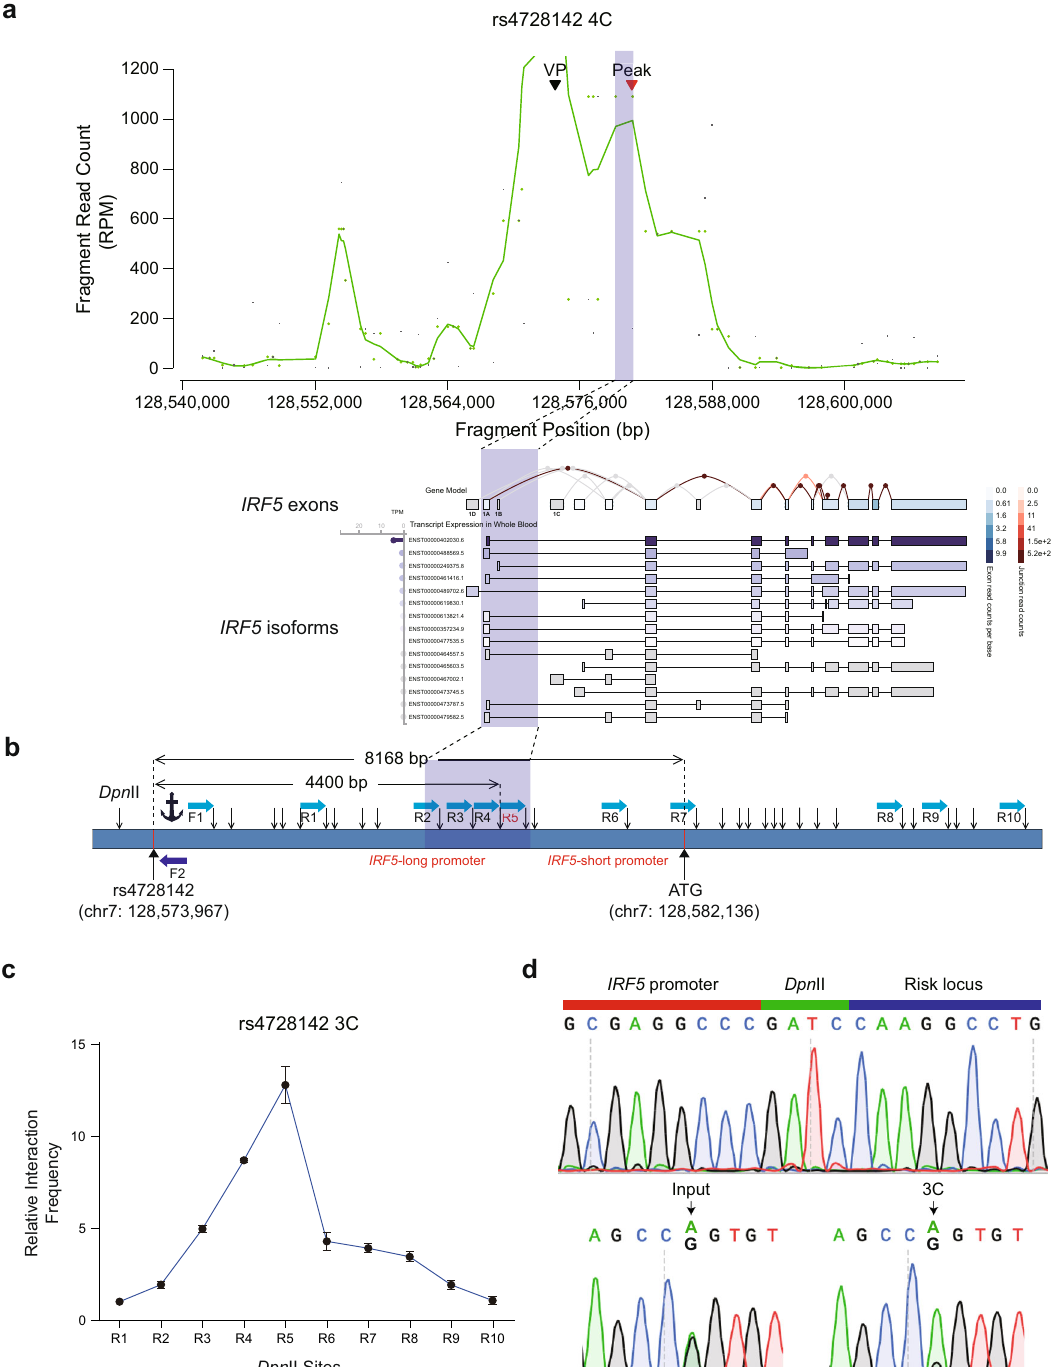
Fig. 3 | The rs4728142-containing region interacts with the IRF5 downstream alternative promoter in an allele-speci fi c manner. a Circularized Chromosome Conformation Capture (4C) assay for the rs4728142-containing region. RPM reads per million. VP (viewpoint) denotes the Dpn II cutting fragment harboring rs4728142. Peak denotes the fragment with the highest interaction frequency. Generallocationinformation(intheshadow)ofthefragmentswithhighinteraction frequencies corresponding to the IRF5 downstream alternative promoter is shown in the bottom graph. IRF5 transcript diagram was extracted from the GTEx portal based on the GENCODE annotation. b A schematic view of Chromosome Con- formationCapture(3C)assayatthers4728142-containingregion.The Dpn IIcutting fragment containing rs4728142 was measured as the bait indicated by an anchor,